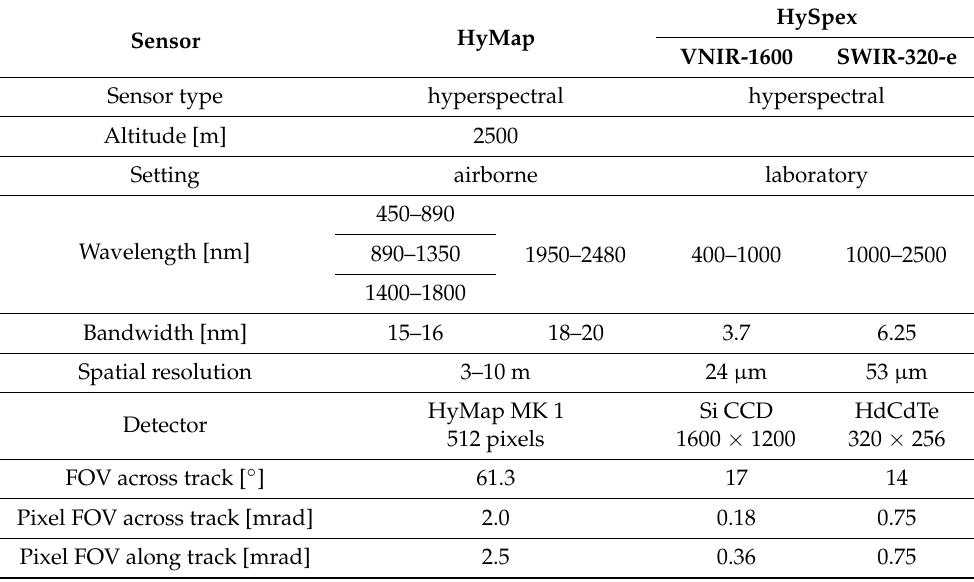
Table 2. Key characteristics of the HyMap hyperspectral sensor [53] and HySpex cameras